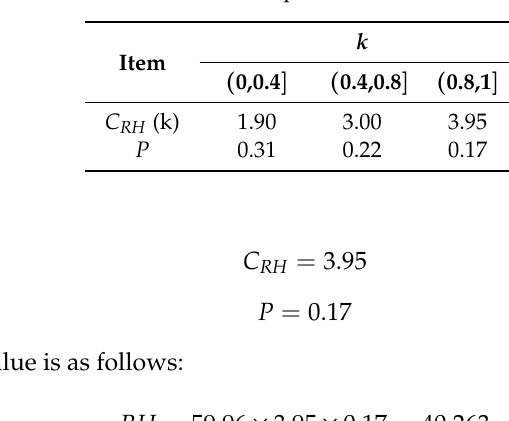
Table 1. Risk parameter